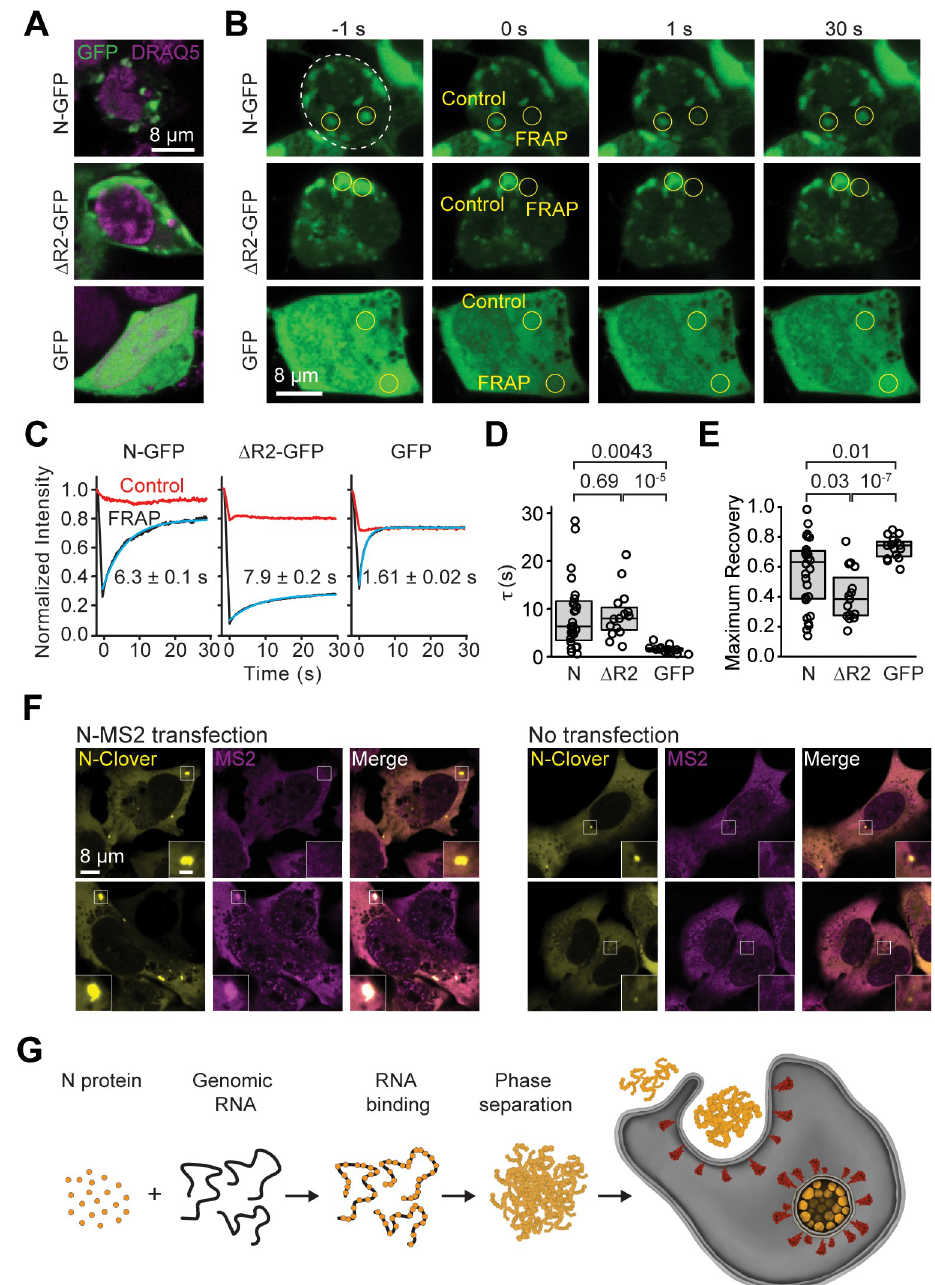
Fig 6. Dynamics of N condensates in vivo. (A) Example images of HEK293T cells expressing N-GFP, Δ R2-GFP, and GFP stained with DRAQ5. (B) Representative FRAP imaging of cells exhibiting N-GFP or Δ R2-GFP puncta or high GFP expression. Circles show the photobleached area. (C) Fluorescence recovery of the GFP signal in the bleached versus the control regions. The solid curve represents a single exponential fit to reveal the recovery lifetime ( τ , ± 95% confidence interval). (D) The distribution of fluorescence recovery lifetimes of cells expressing N-GFP ( n = 28) or Δ R2-GFP ( n = 15) exhibiting puncta and GFP only ( n = 15). The center and edges of the box represent the median with the first and third quartiles. The p -values were calculated from a 2-tailed t test. (E) The maximum fractional recovery after photobleaching of cells expressing N-GFP ( n = 28), Δ R2-GFP ( n = 15), or GFP only ( n = 15). The center and edges of the box represent the median with the first and third quartiles. The p -values were calculated from a 2-tailed t test. (F) U2OS cells stably expressing N-Clover form condensates in the cytoplasm. (Left) Cells co-transfected with an N-MS2 expression plasmid exhibit colocalization of N-Clover and Cy3-MS2 FISH signal in N-condensates ( N = 10 out of 55 cells, 2 technical replicates). (Right) The Cy3-MS2 FISH probe does not partition into N